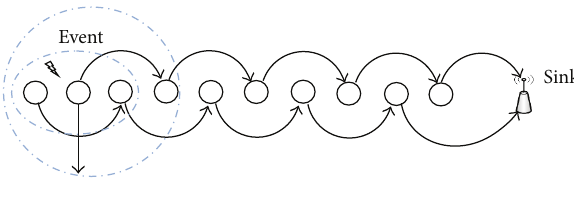
Figure 1: Event reporting scenario in